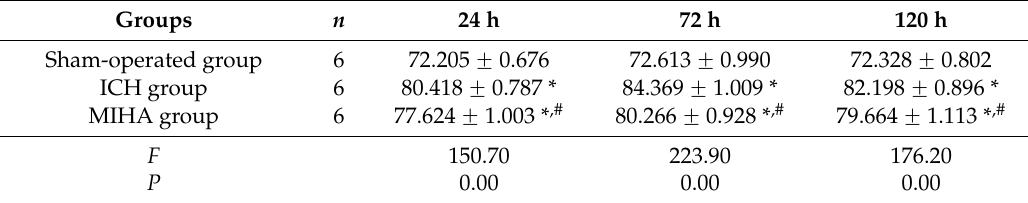
Table 2. The brain water contents (BWCs) of rats in different groups at each time point ( x ± s, %). Groups n 24 h 72 h 120 h